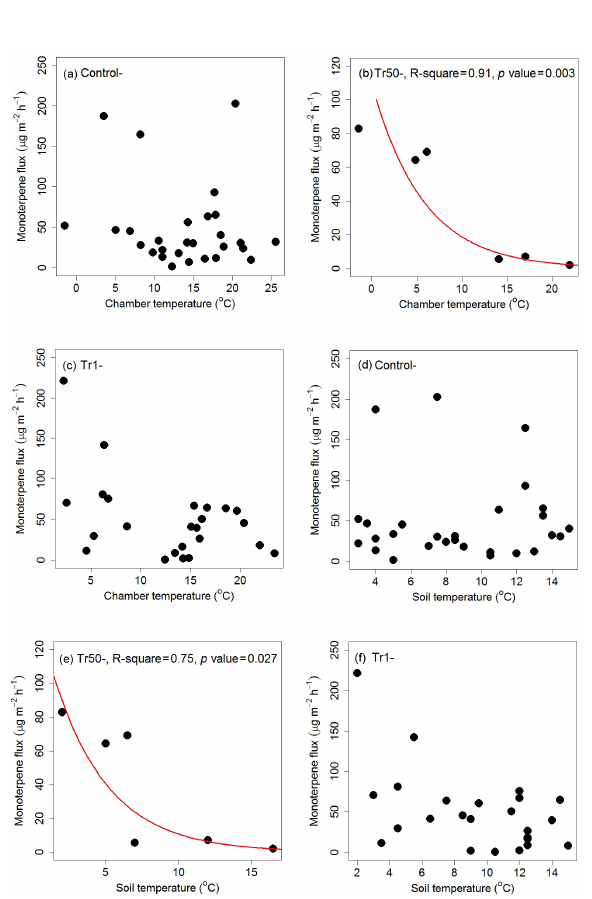
Figure A2. Relationships between monoterpene flux (µgm − 2 h − 1 ) and chamber temperature ( ◦ C) on Control − (bare soil was non-trenched), Tr50 − (bare soil where ingrowth of mycorrhizal fungi was allowed), and Tr1 − (bare soil where decomposers were the only source) plots (a, b, c) and soil temperature ( ◦ C) on Control − , Tr50 − , and Tr1 − plots (d, e, f) . The presented data were combined from all the periods in 2015. The regression coefficient and p value are indicated where the regression was